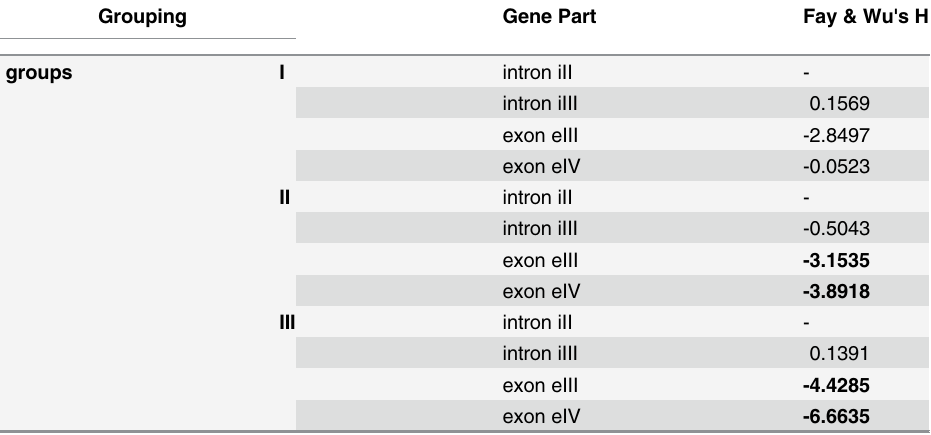
Table 7. Fay and Wu ’ s H neutrality test for the Ch α E7 gene.